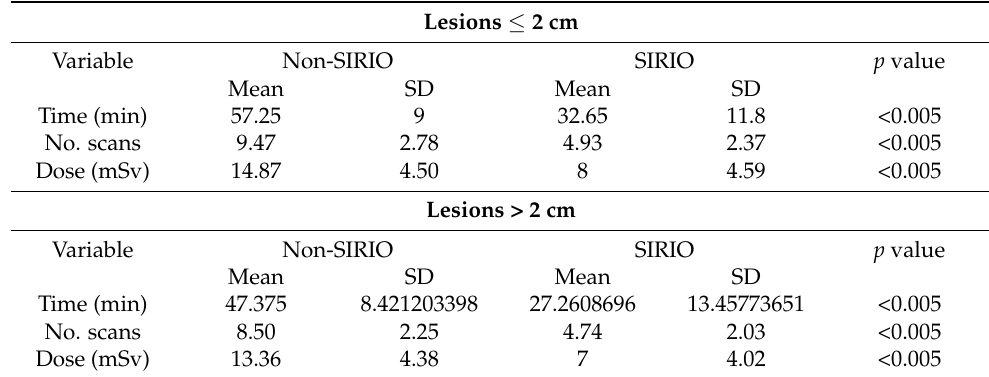
Table 2. Showing mean procedural time, number of CT scans and Radiation Dose for each group.